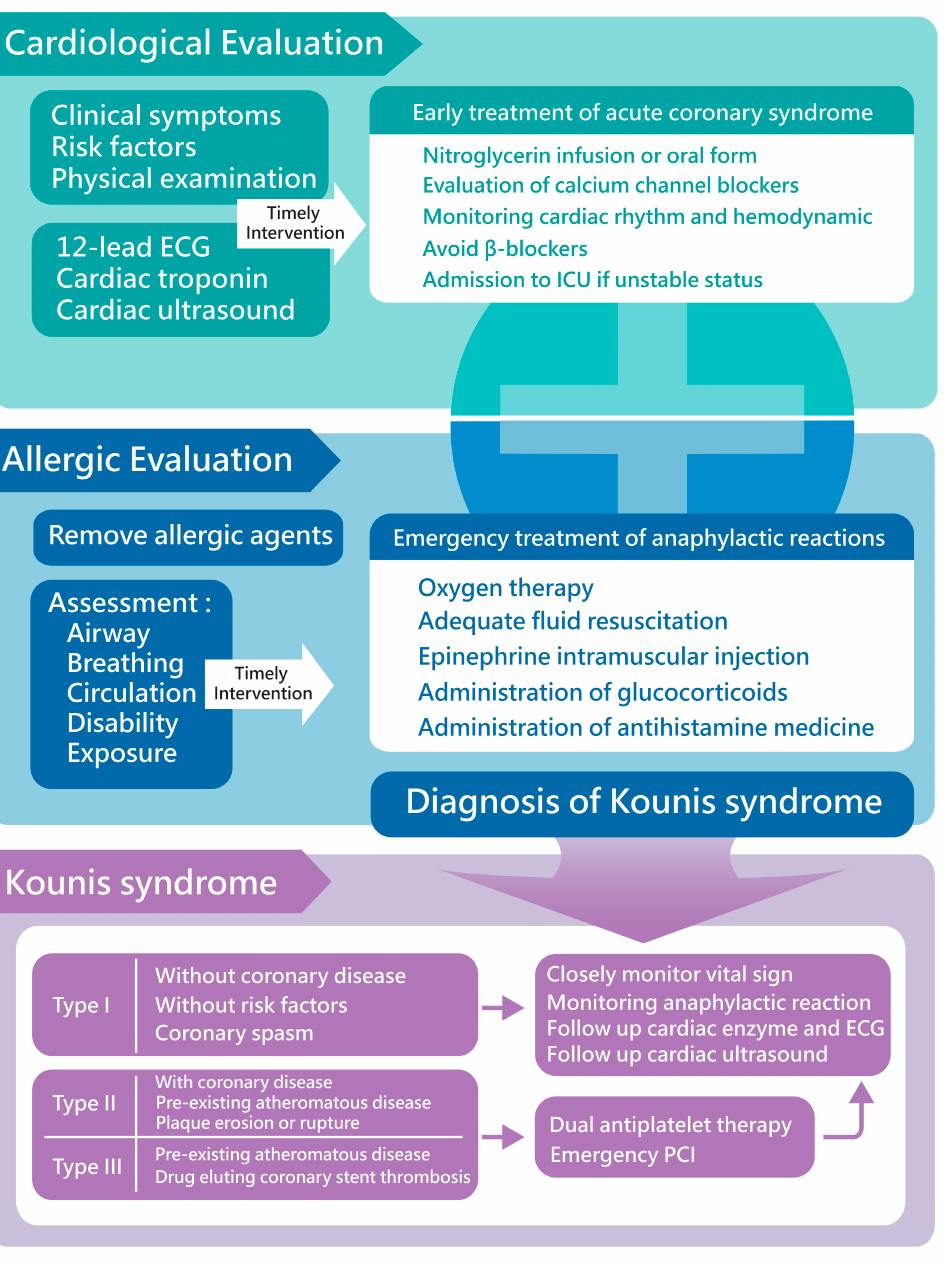
Figure 5. The detailed management of Kounis syndrome.